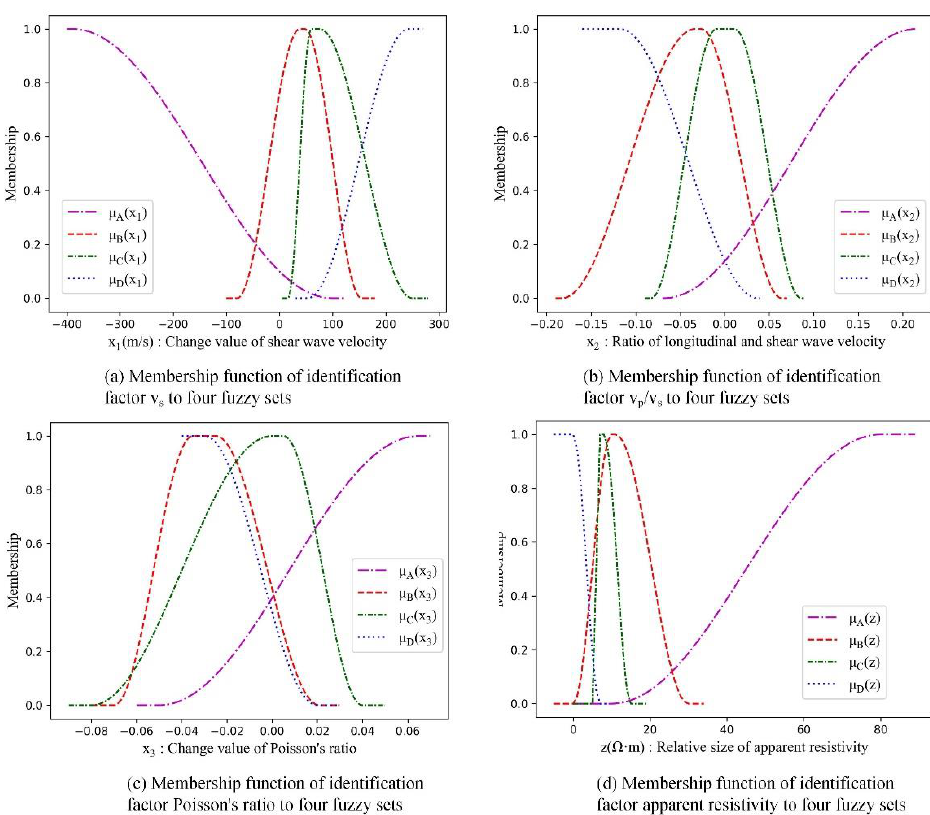
Figure 8. Membership functions of different identification factors. Table 1. Membership degree of GPR identification factors to effluent fuzzy